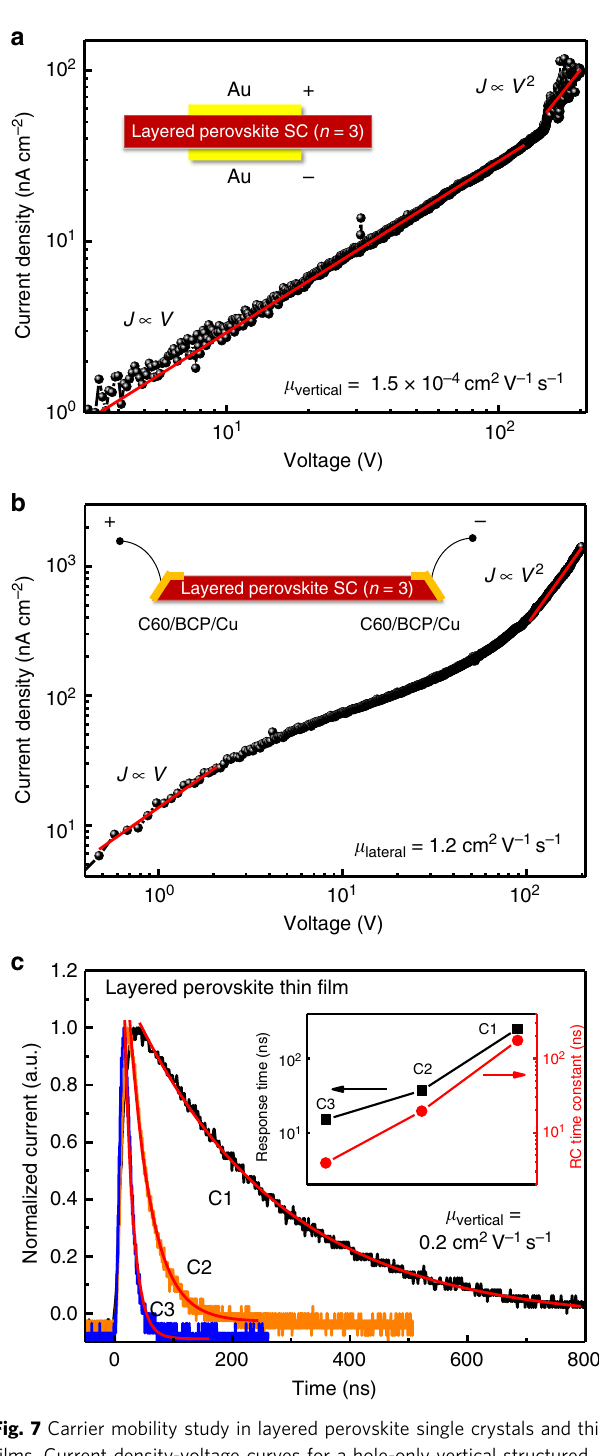
Fig. 7 Carrier mobility study in layered perovskite single crystals and thin fi lms. Current density-voltage curves for a hole-only vertical structured layered perovskite single crystal (SC) device ( a ) and an electron-only lateral-structured layered perovskite SC device ( b ). The insets show the device structure of vertical and lateral devices, respectively. c Transient photocurrent (TPC) curves of layered perovskite thin fi lm solar cells with decreased working area (from C1 to C3). The inset is the measured RC time constant of the device as well as the fi tted decay time of the TPC curves with different device working areas. The red lines are the fi tting curves to the